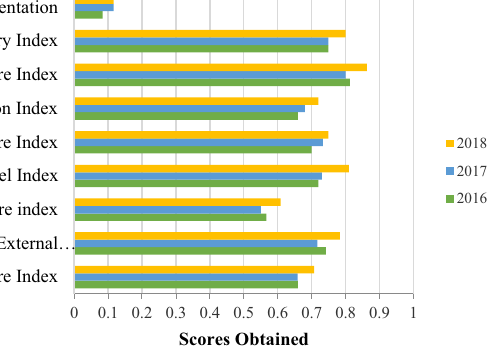
Figure 2. Graphical representation of the mean scores obtained by each index